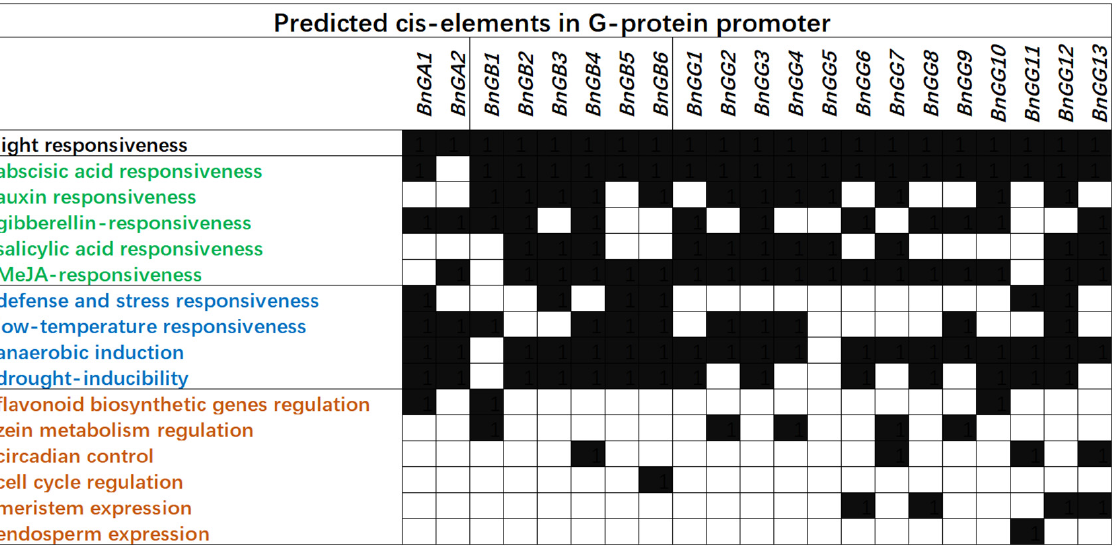
Figure 6. Predicted cis-elements in B. napus G-protein promoters. Promoter sequences (2000 bp) of 21 G-proteins are analyzed by PlantCARE. Cis-elements were identified in the promoters of all 21 G-proteins and were classified into four main groups (black, green, blue, and orange, respectively, represent groups). Black means that gene has one cis-element at least, and white means that there is no cis-element.